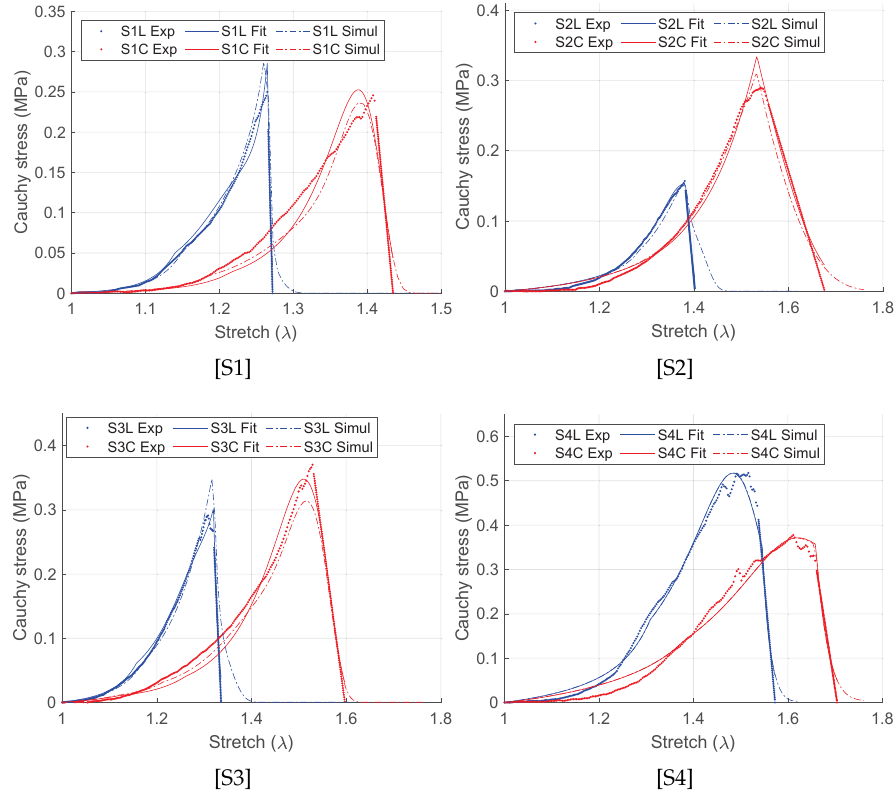
Figure 5. Fitting of the representative stress–stretch curves using damage formulation (Equation (17)). “Exp” represents the experiment data set, “Fit” represents the Matlab curve fit data set, and “Simul” represents the simulation